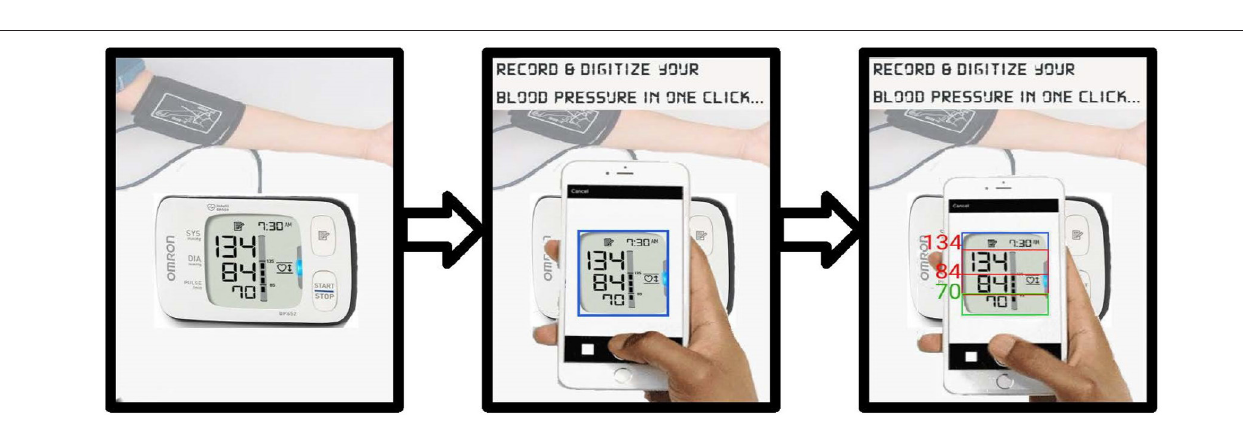
FIGURE 2 | Steps of image transcription using cellphone